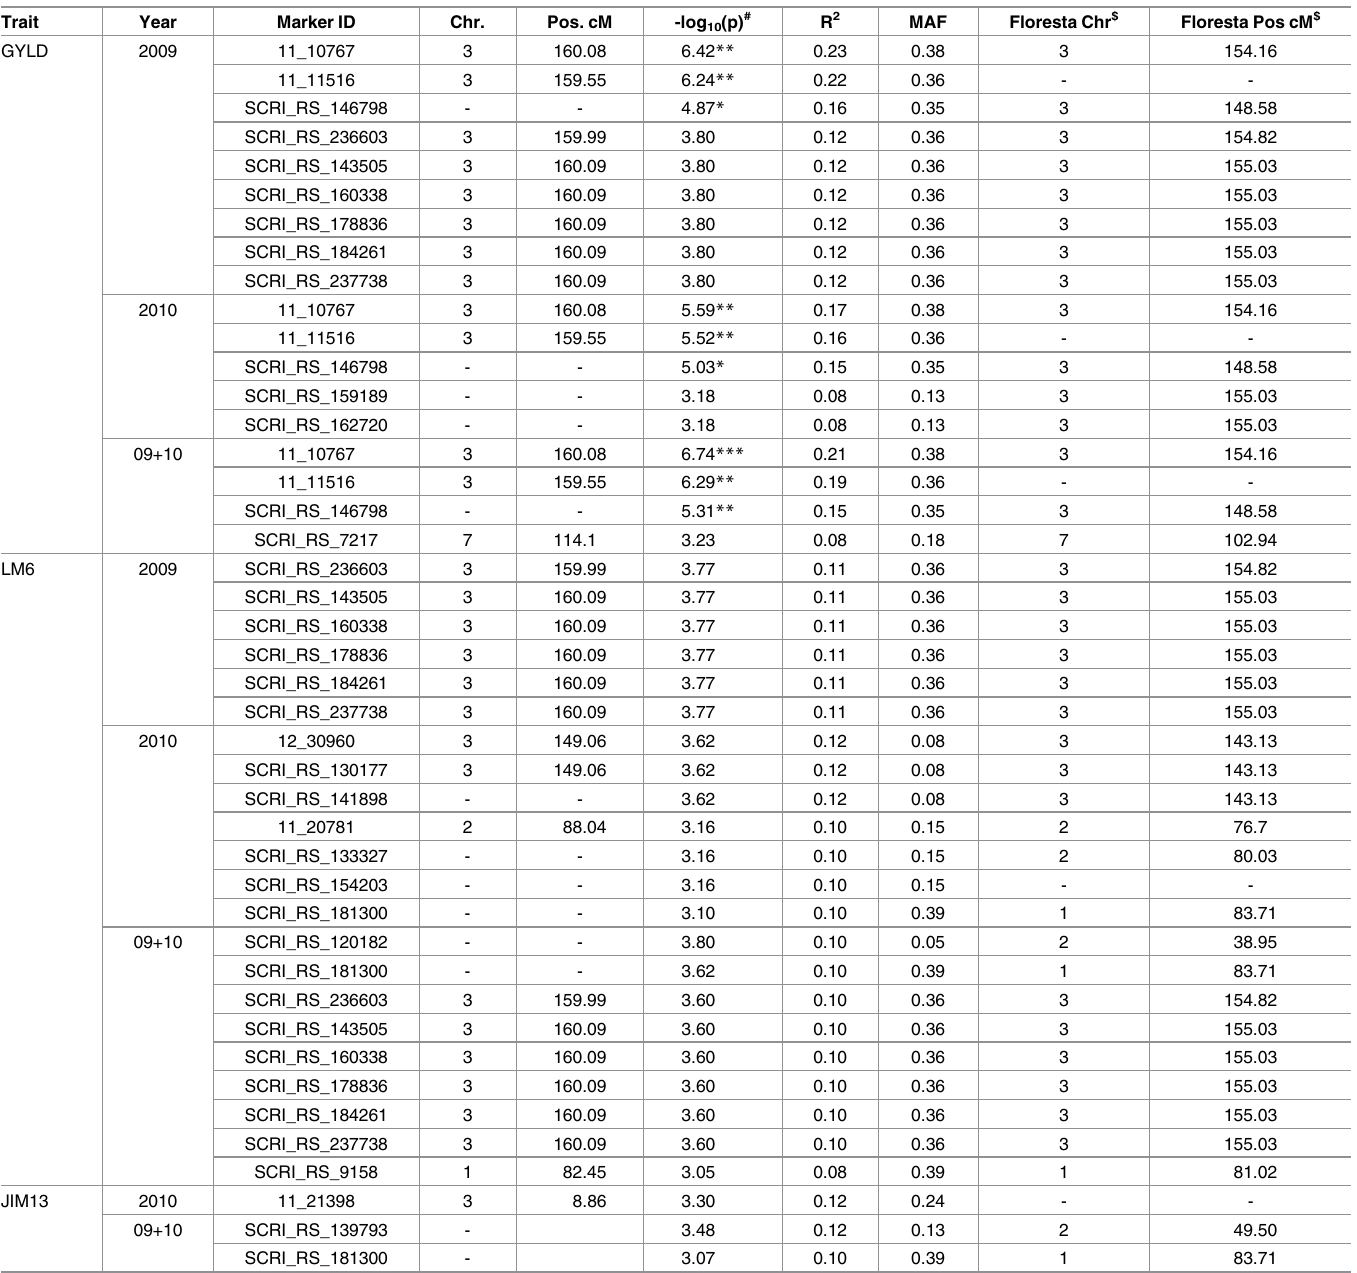
Table 3. GWAS results.